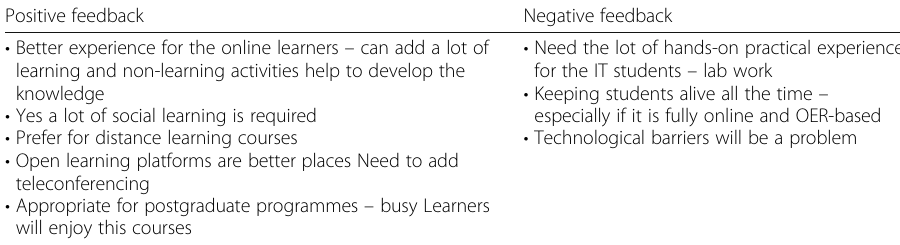
Table 5 Review on conducting OER-based courses Positive feedback Negative feedback